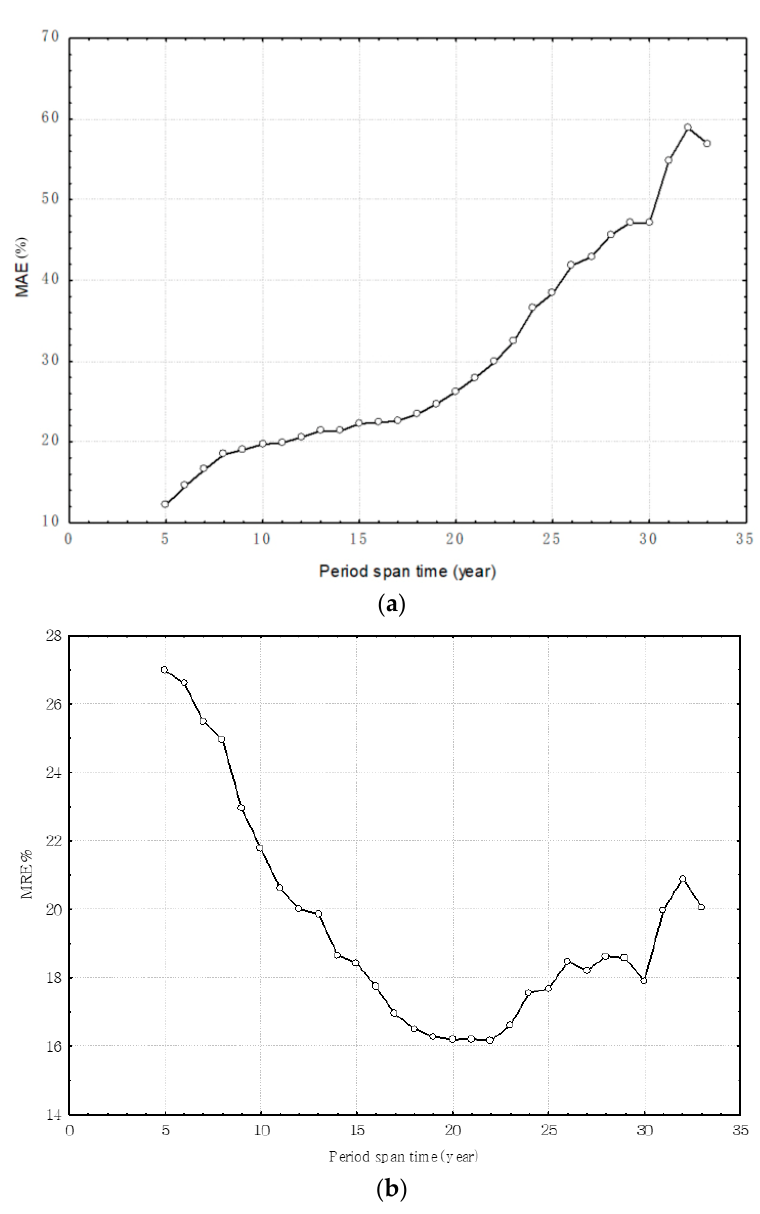
Figure 7. ( a ) MAE and ( b ) MRE of predicted fire number of periods ranging from 5 to 33 years.